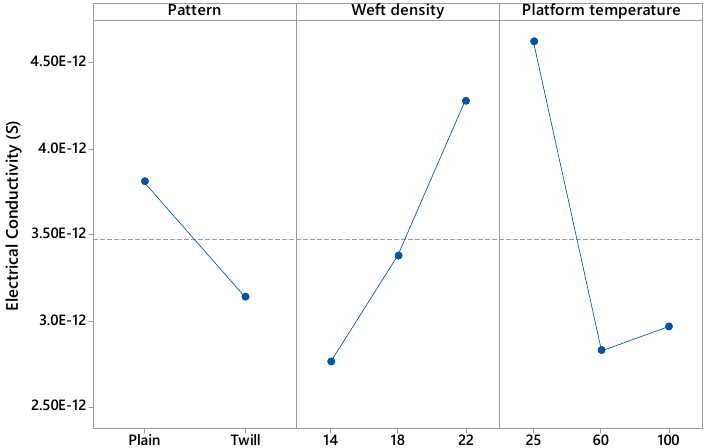
Figure 15. Influence of pattern (plain and twill), weft density (14,18 and 22 picks / inch) and platform temperature (25, 60 and 100 °C) on the electrical conductivity (S) of the samples after abrasion (20 K cycles). In y-axis the following scientific notation 2.50E-12 means 2.50 × 10 −12 .